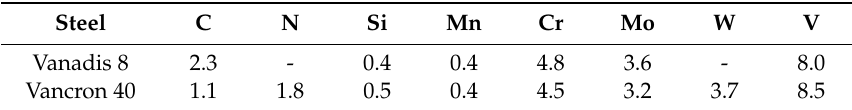
Table 1. Chemical compositions of tool steels (wt. %).